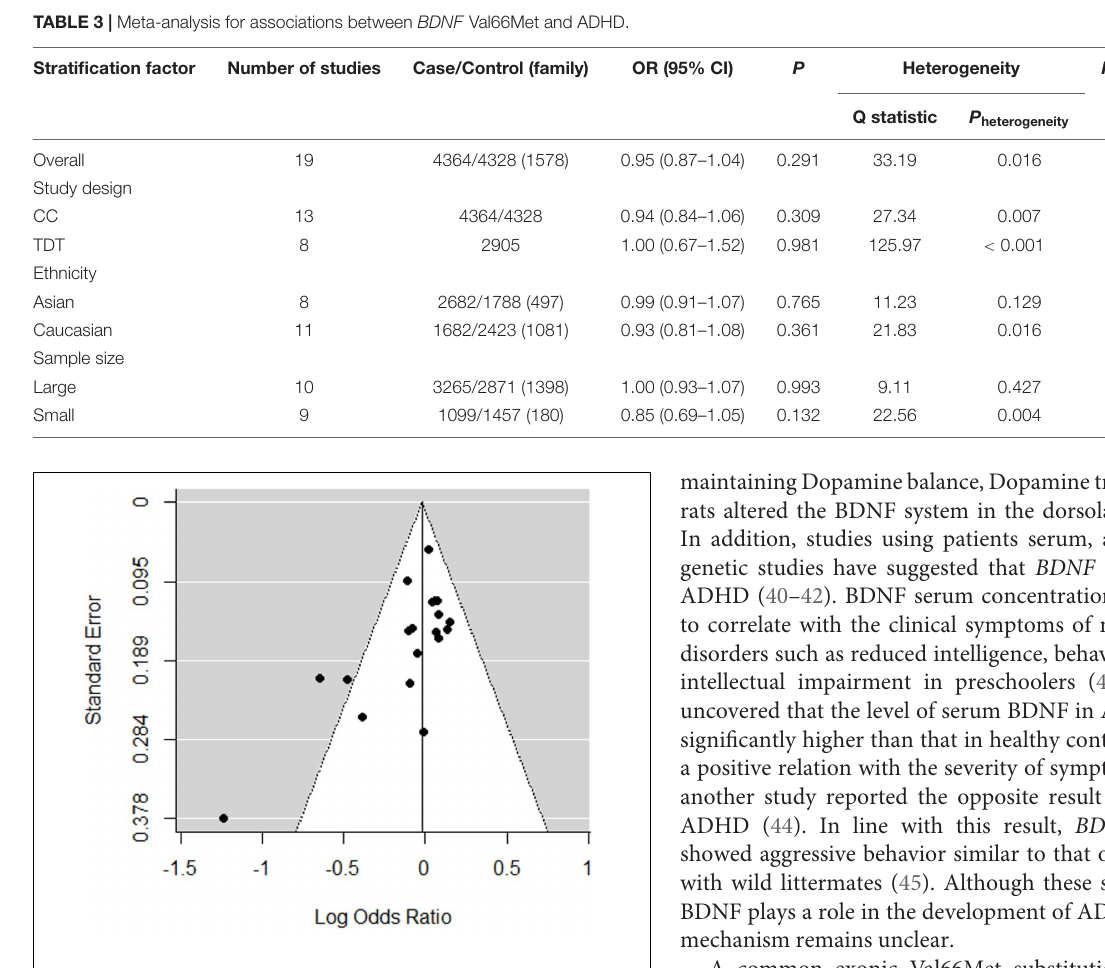
FIGURE 3 | Funnel plot of the association between rs6265 and attention deficit hyperactivity disorder (ADHD) risk.